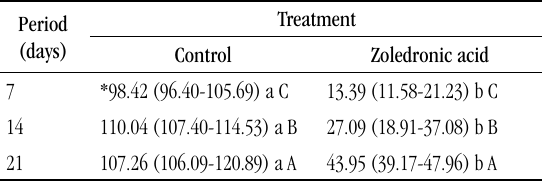
tABLE 2 – Formation of mineralized nodules (%) of SaOs-2 cells, according to treatment and assessment period